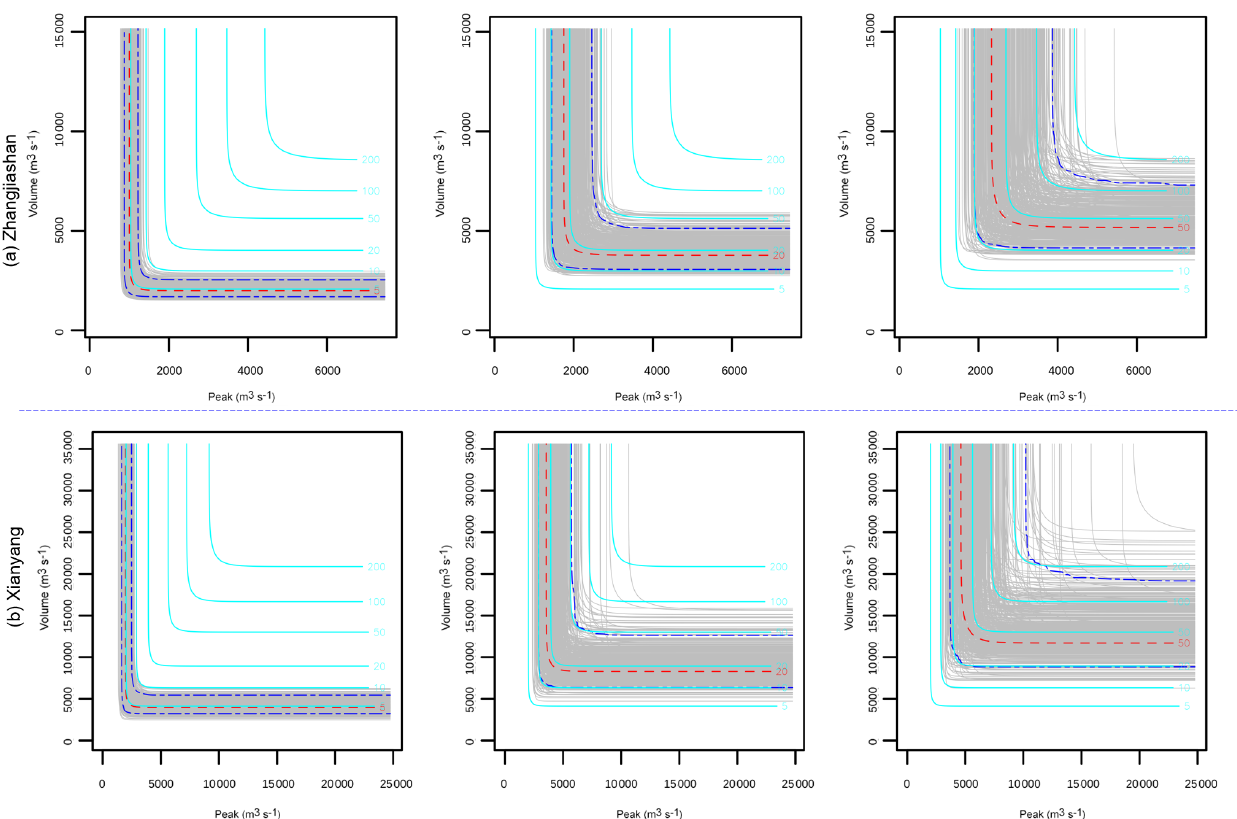
Figure 6. Uncertainty quantification of the joint RP in “Kendall”: the red dash lines indicate the predictive means, the two blue dash lines, respectively, indicate the 5% and 95% quantiles, and the grey lines indicate the predictions under different parameter samples with the same joint RP of the red and blue dash lines. The cyan lines denote the predictions under different return periods, with the model parameters being their mean